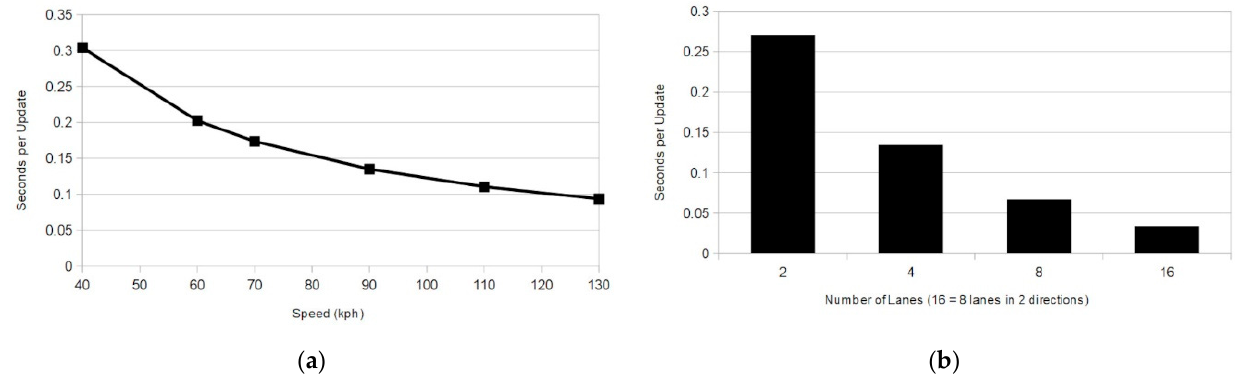
Figure 6. Seconds between key updates due to departing OBUs: ( a ) Single lane of traffic at various speeds; ( b ) Traffic moving at 90 kph.